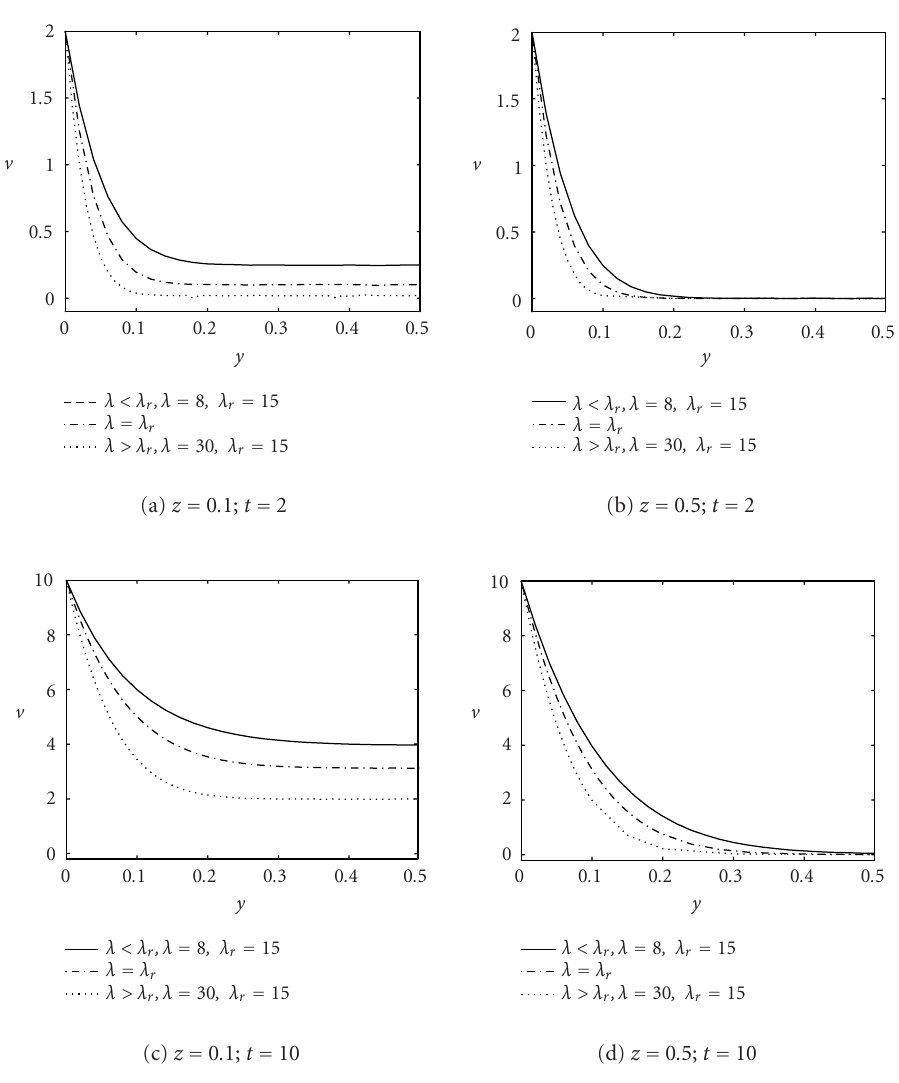
Figure 5.1. Velocity profiles v corresponding to λ < λ r , λ = λ r , and λ > λ r for A = 1 . 0, ν = 0 . 0011746, for z = 0 . 1 and z = 0 . 5cm, and t = 2 and 10s, respectively.